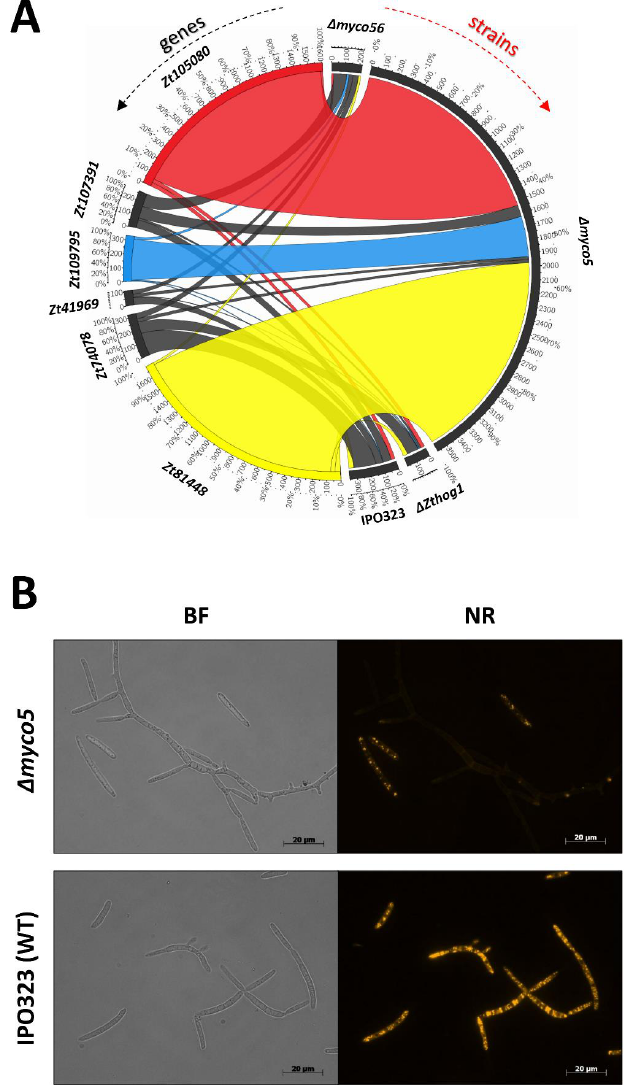
Figure 9. Aberrant lipid metabolism in the strain ∆ myco5 . ( A ) CircosPlot visualization of the RNA-Seq transcriptomic data regarding the genes predicted to encode phospholipases and esterases. Zt105080 , Zt109795 and Zt81448 were shown to be highly transcribed in ∆ myco5 compared to WT and other the strains examined. ( B ) Imaging the lipid content of the ∆ myco5 strain. Localization of neutral lipids was visualized by Nile Red staining in IPO323 and the ∆ myco5 strain. BF, bright field microscopy; NR, Nile Red